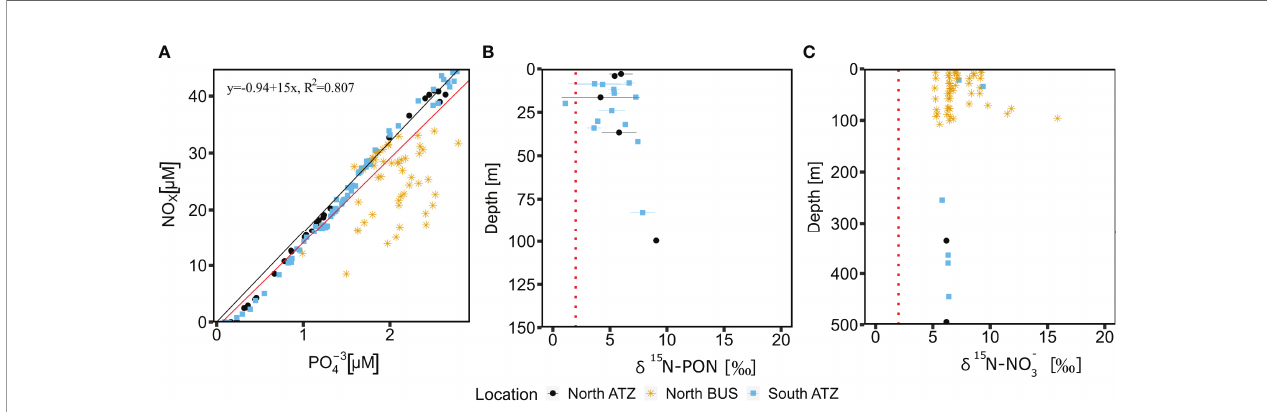
FIGURE 2 | NO x over PO 3 − 4 concentrations from all sampled stations (A) . The N:P ratio is around the Red fi eld ratio of N:P = 16:1 (black line). The linear regression equation (red line) has a negative intercept suggesting a slight N limitation. Samples from the North BUS OMZ are an exception, as those show an undersaturation of N suggesting active N loss processes. d 15 N-PON (B) and d 15 N − NO − 3 (C) shows no indication of active N 2 fi xation but rater N-loss (denitri fi